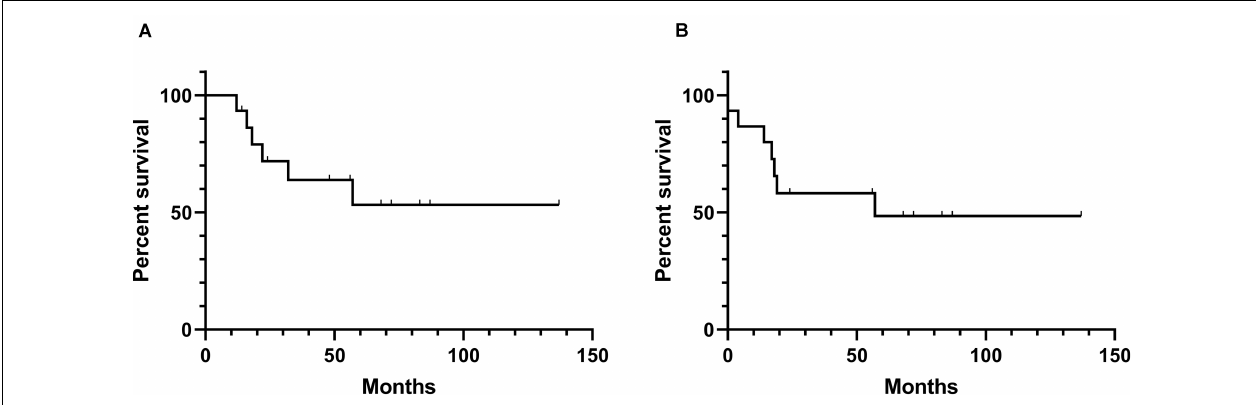
FIGURE 3 | Kaplan–Meier curves of overall survival and progression-free survival of the reported effects (101) of SSTR-related radiation therapy. (A) Overall survival. (B) Progression-free